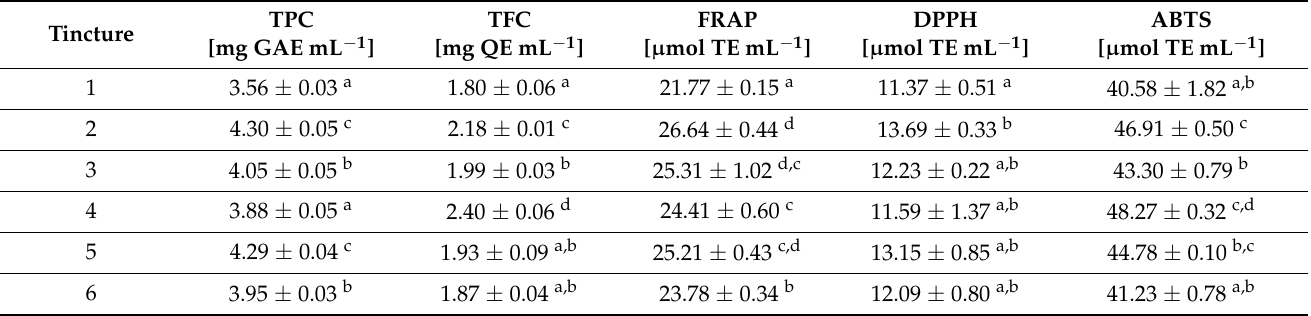
Table 2. Polyphenolic and flavonoids contents as well as antioxidant properties of green walnut